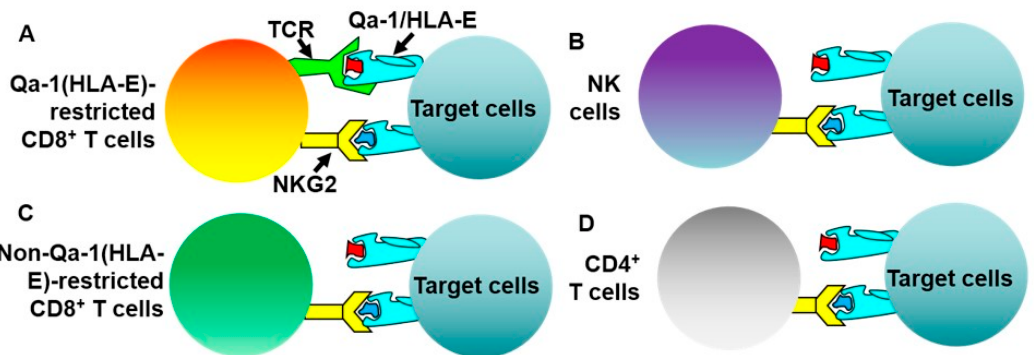
Figure 1. Qa-1(HLA-E)-restricted CD8 + T cells may express both TCRs and NKG2 receptors that are capable of interacting with Qa-1(HLA-E) molecules. Qa-1(HLA-E)-restricted CD8 + T cells ( A ) may express both TCRs and NKG2 receptors which can interact with Qa-1(HLA-E) molecules. NK cells ( B ), non-Qa-1(HLA-E)-restricted CD8 + T cells ( C ), and CD4 + T cells ( D ) only express NKG2 receptors. Color codes are used for distinguishing different types of cells and molecules only.